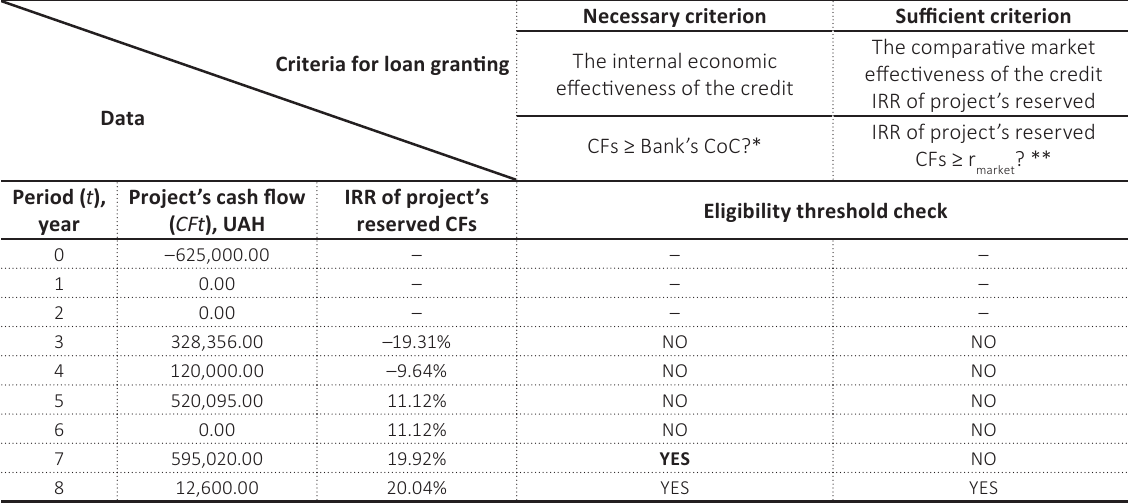
Table 5. Numerical illustration: Lending capacity assessment and loan terms calculation for rearranged cash